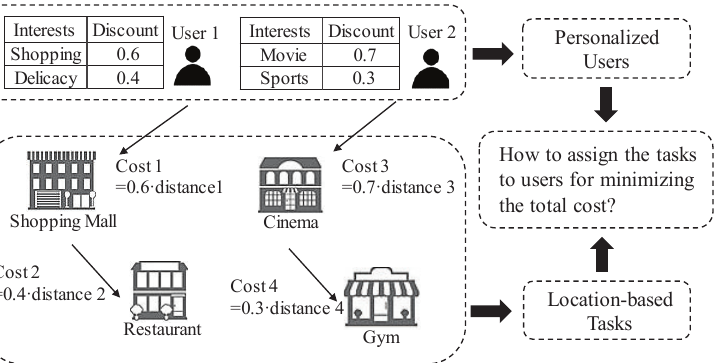
Figure 1. Personalized task allocation strategy for mobile crowdsensing. The cost for a user to finish a sensing task depends on not only the distance but also the user’s interest on the location of task. Then the problem is transformed into how to assign the tasks to users for minimizing the total